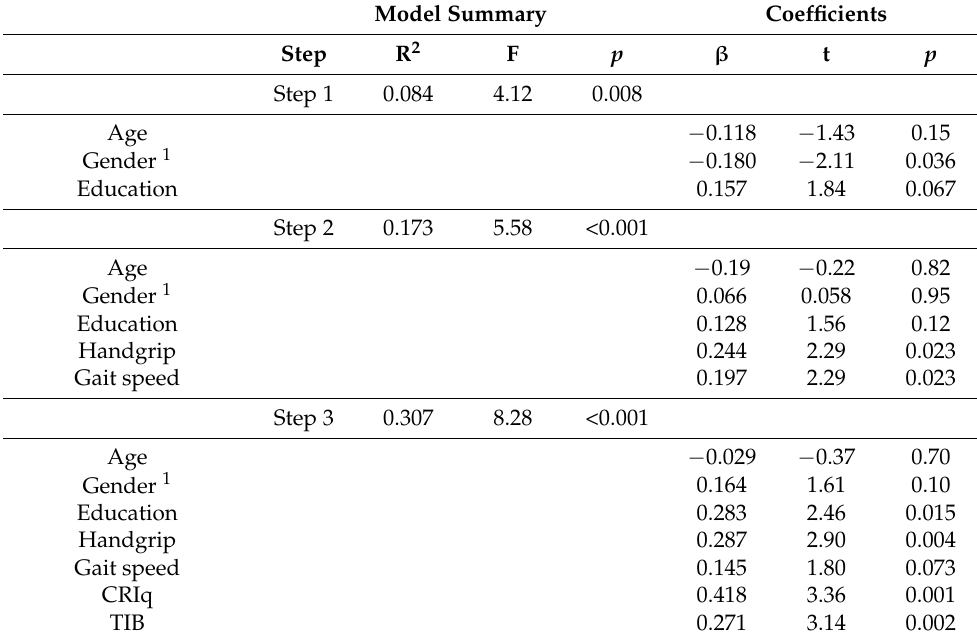
Table 3. Hierarchical multivariate linear regression model for baseline MMSE